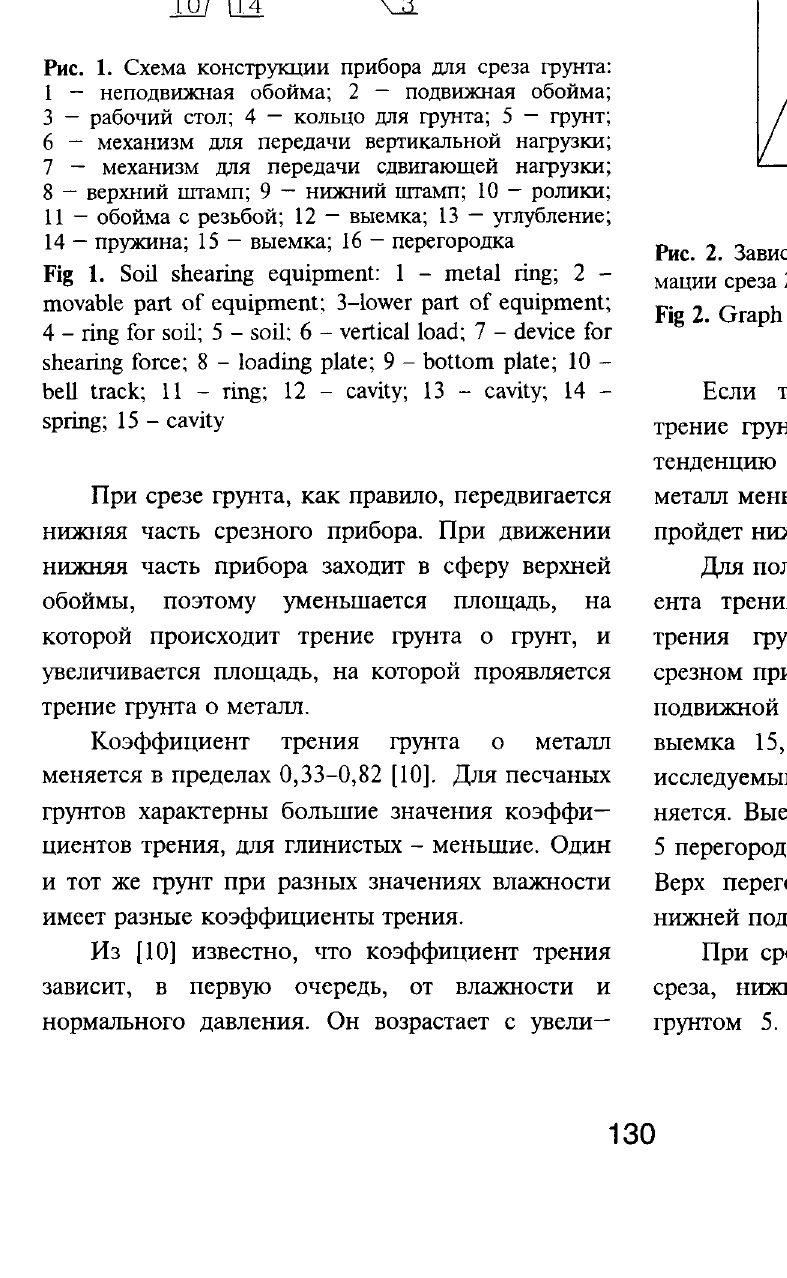
Fig 2. Graph of shear resistance t against strain